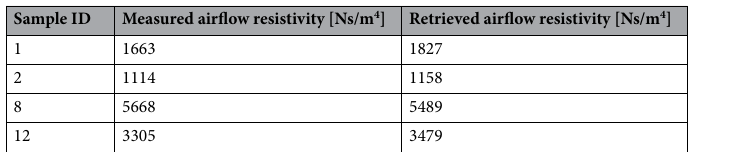
Table 3. Validation of the process—airflow resistivity.